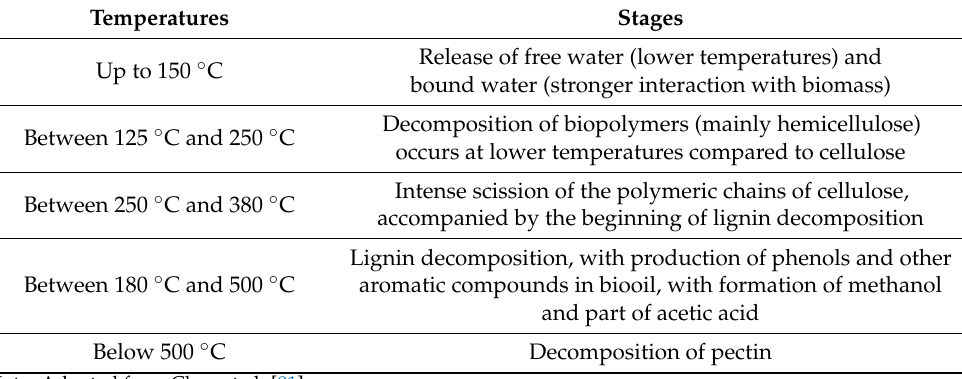
Figure 9. Recording of the microstructural characteristics of biochar after use as a filter element. Table 5. Temperature ranges and stages in the biomass pyrolysis